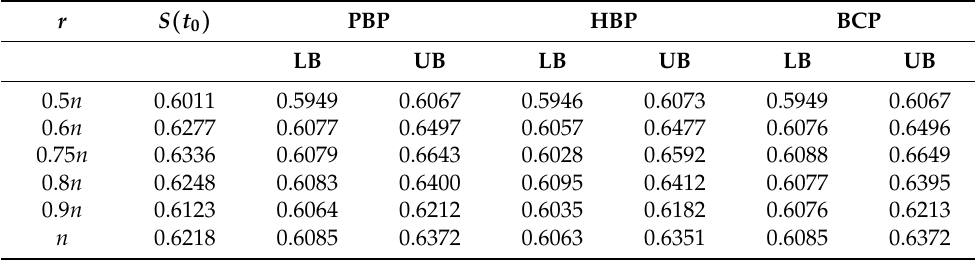
Table 8. 95% Confidence intervals of survival function at x 0 = 2 for windshield.